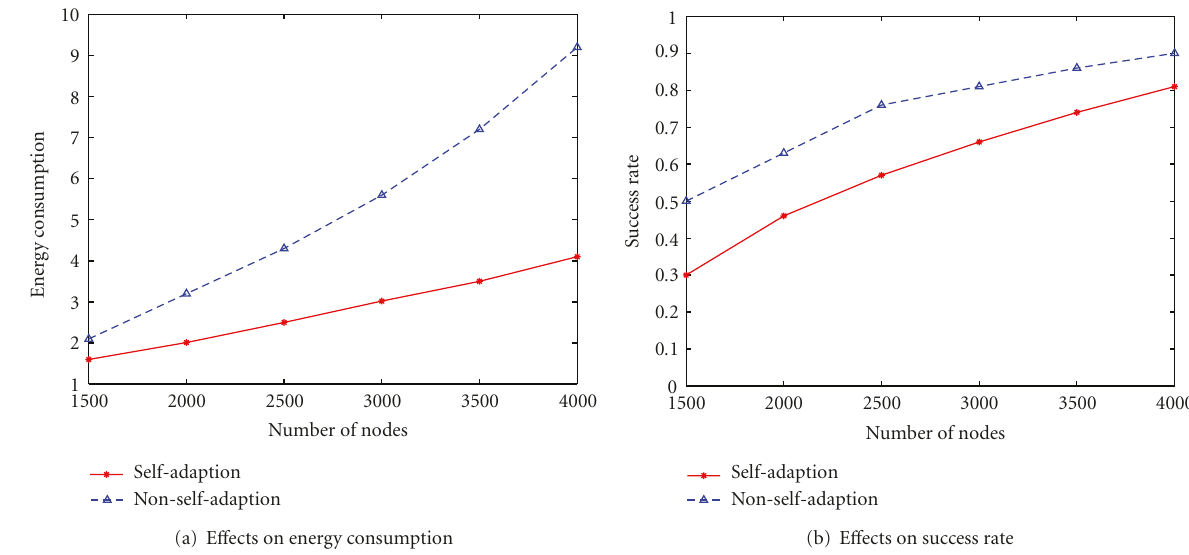
Figure 5: The performance of VBF with and without self-adaptation algorithm.